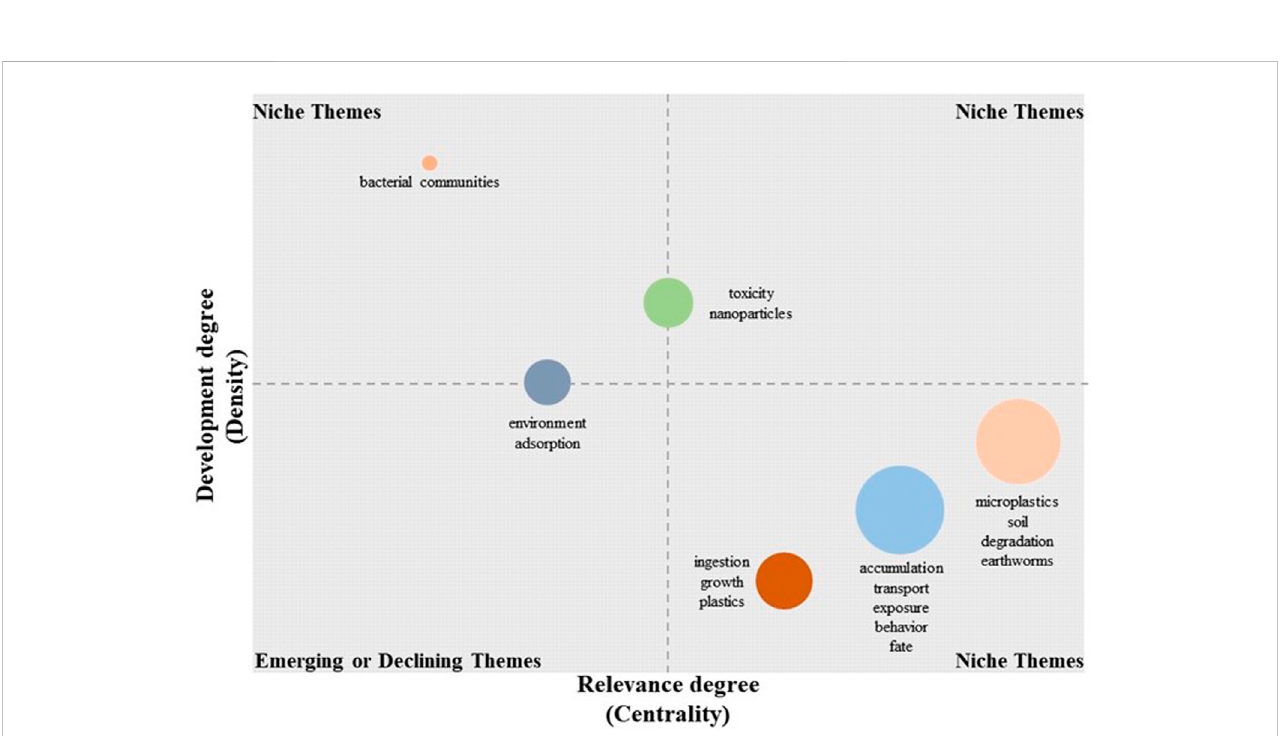
FIGURE 6 Keyword clustering of articles published from 2018 to 2019 focusing on microplastics and earthworms. The minimum frequency of occurrence (per 1,000 documents) for each research direction is more than fi ve. The size of the circles represents the number of articles published in the corresponding direction. The horizontal axis represents relevance (centrality), which measures the importance of a research direction in the overall development of the research fi eld. The vertical axis represents development (density), which measures the current state of development of a research